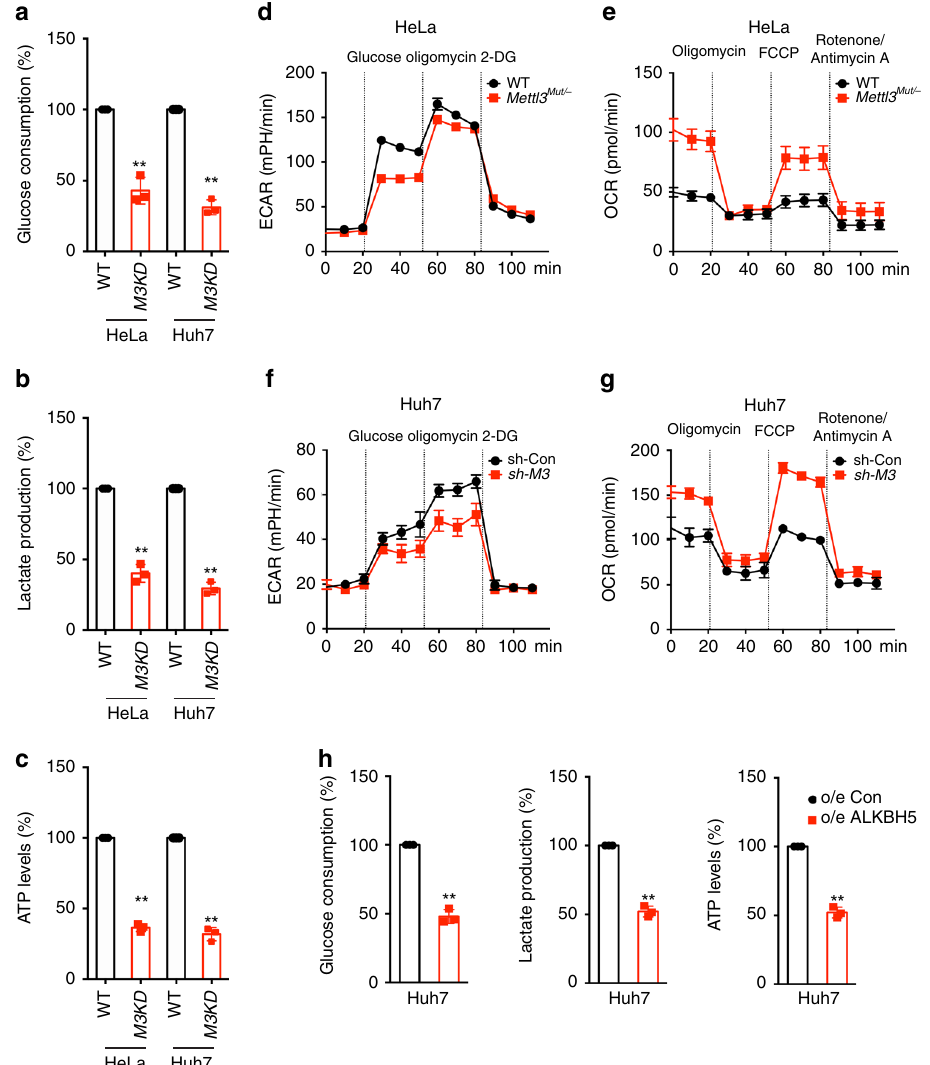
Fig. 1 m 6 A regulates glycolysis and ATP generation of cancer cells. a – c The glucose consumption ( a ), lactate production ( b ), and ATP levels ( c ) in Mettl3 Mut/- HeLa, sh- Mettl3 Huh7 and their corresponding control cells. d , e The cellular ECAR ( d ) and OCR ( e ) were measured in wild type and Mettl3 Mut/- HeLa cells. f , g The cellular ECAR ( f ) and OCR ( g ) were measured in sh-control and sh- Mettl3 Huh7 cells. b The glucose consumption, lactate production, and ATP levels in Huh7 cells transfected with vector control or ALKBH5 constructs. Data are presented as the mean ± SD from